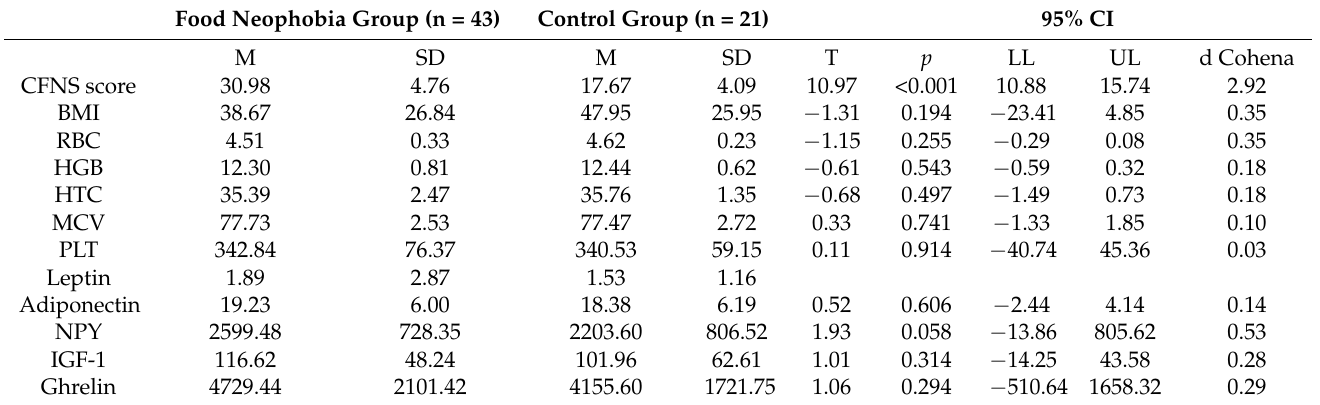
Table 3. Comparison between the neophobia group and the control group.